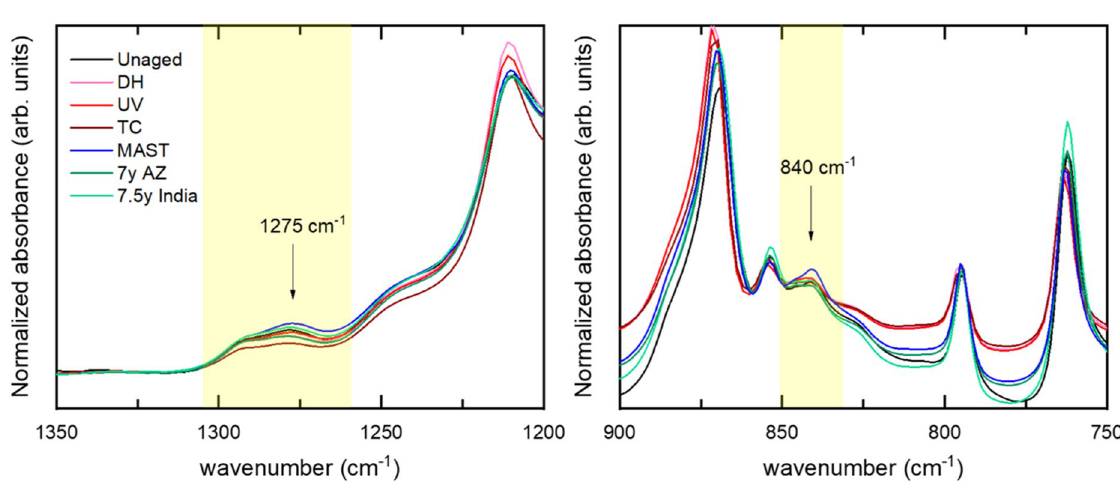
Figure 6. FTIR spectra of PVDF-B, focusing on the regions of spectra specific to PVDF